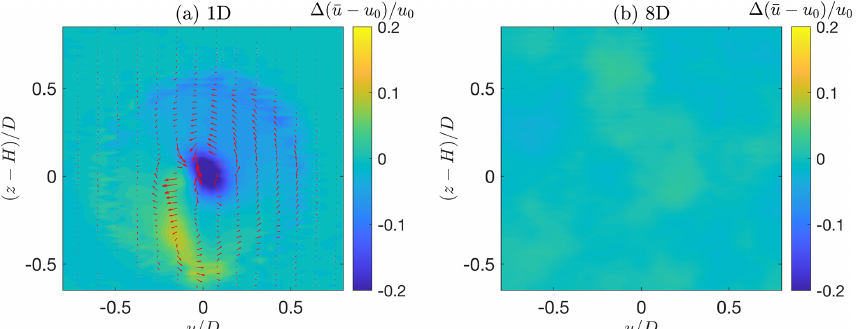
Figure 13. Difference in the wake velocity fields, obtained subtracting the G178-MC solution from the G1 one, looking upstream. Color field: streamwise velocity deficit difference (cid:49) ( u − u 0 ) /u 0 ; arrows: difference in the in-plane velocity vectors. (a) Near wake 1 D immediately behind the rotor disk plane. (b) Far wake at 8 D .